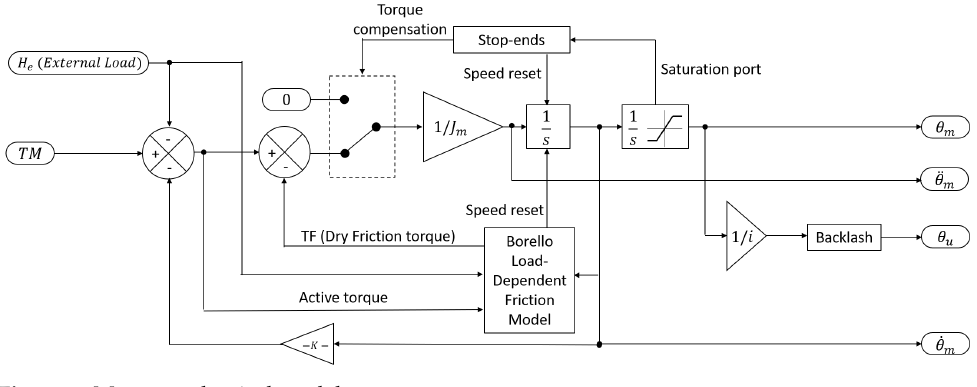
Figure 5. Motor mechanical